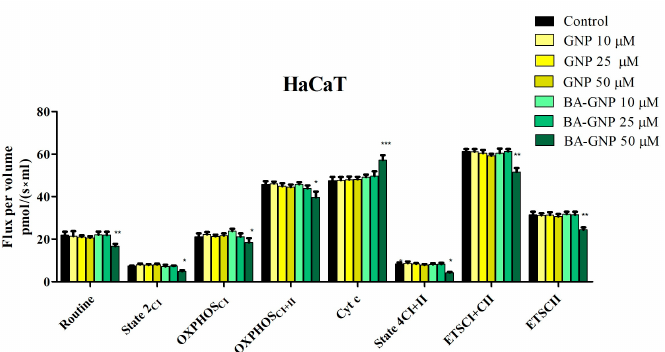
Figure 12. Mitochondrial respiration of immortalized human keratinocytes—HaCaT cells after 24 h treatment with GNP (diluted to match the same gold content as for BA-loaded NPs at 10, 25 and 50 μΜ )) and BA-GNP (10, 25 and 50 μΜ ). Data represent the mean ± SD of five individual experiments. Values with p < 0.05 were considered to have a statistically significant difference (* p < 0.05, ** p < 0.01 and *** p <0.01). The respiratory parameters displayed represent the following: Routine—respi- ration of cells suspended in a substrate-free media; State 2 CI : CI-driven mitochondrial respiration in basal conditions—LEAK, OXPHOS CI —active respiration dependent on CI substrates and exogenous